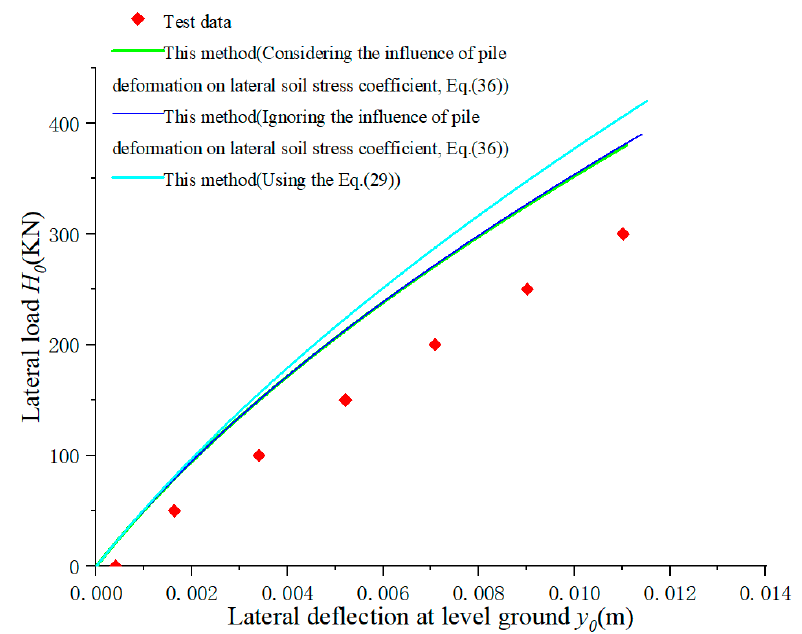
Figure 11. Comparison with load-de fl ection test results of 3D FE model.